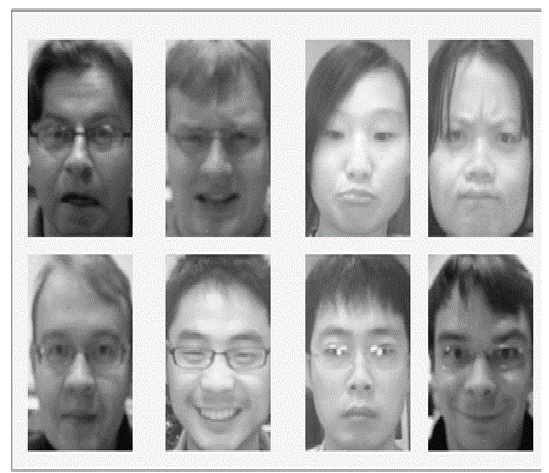
Figure 13. Samples in Oulu-CASIA dataset .